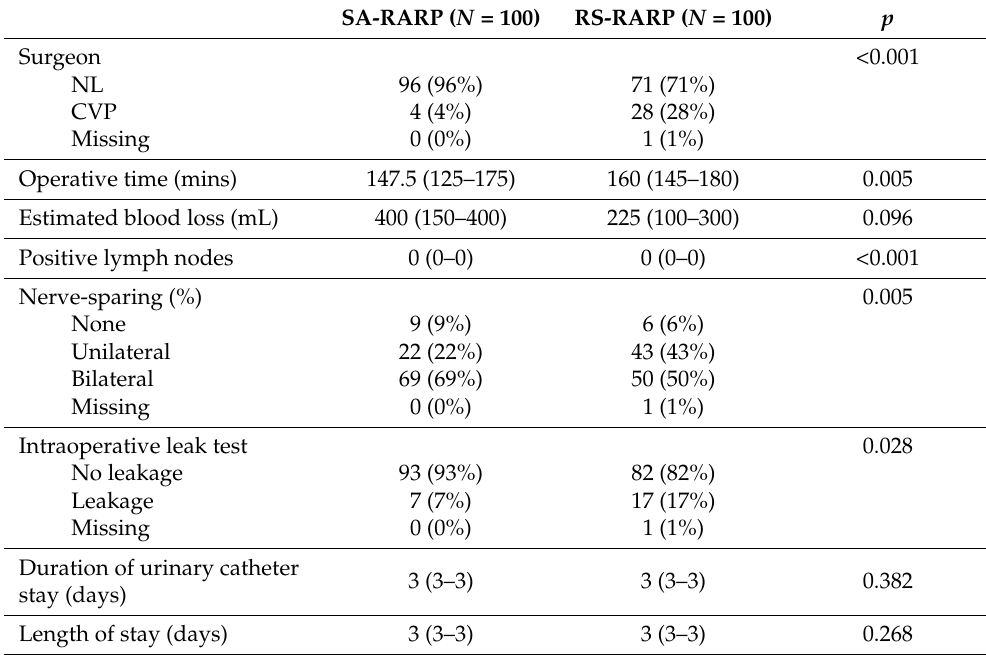
Table 2. Intraoperative and early postoperative data in the SA-RARP and RS-RARP groups.